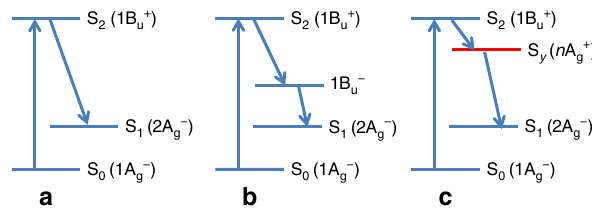
Fig. 1 Photophysics model of carotenoids. The three-state model ( a ), the four-state model involving 1B u − ( b ) and the new four-state model containing S y ( c ) used to interpret the excited-state dynamics of